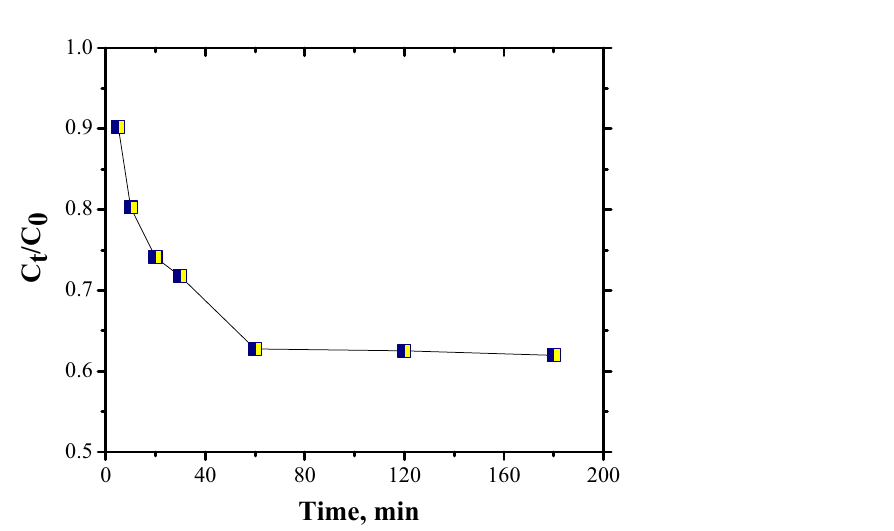
Figure 10. Kinetics of adsorption of Congo Red